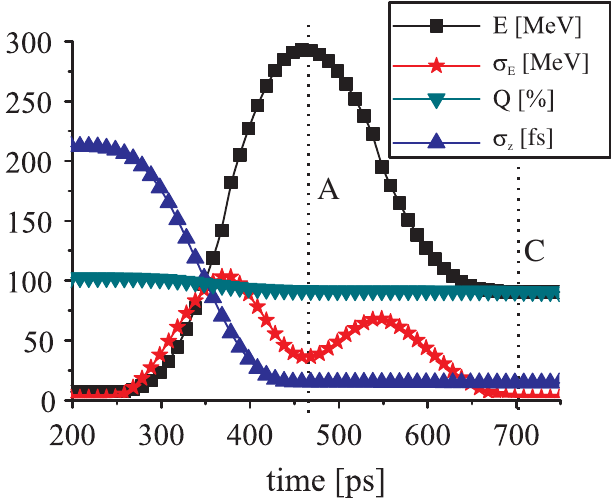
FIG. 4. (Color) Time evolution of the normalized RMS emit- ) and the longitudinal tance in the transverse direction ( " N R RMS direction ( " N ) as well as the total amount or charge left in the Z RMS bunch ( Q